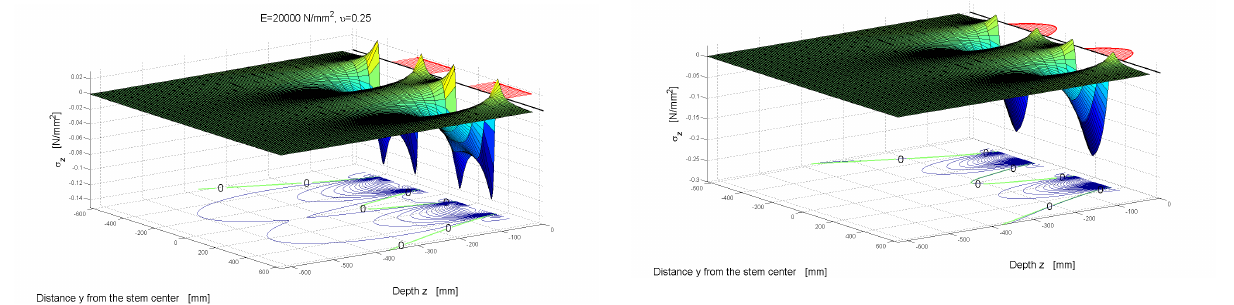
Figure 39: 3-D surface and stress contours of σ z on the A-A vertical cross-section of Figure 38 (second order solution).